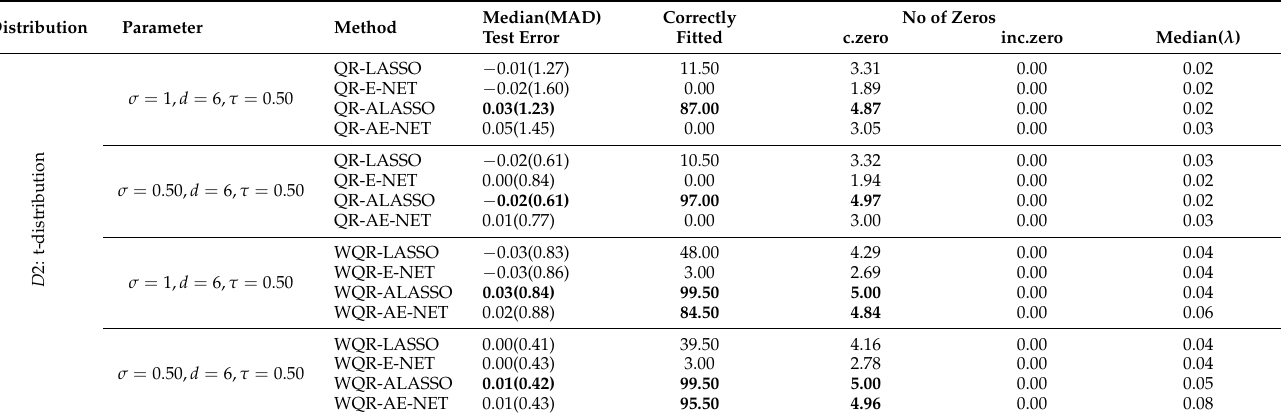
Table A3. Penalized weighted and unweighted quantile regression at D 2 for n = 50 ( τ = 0.50) under the heavy tailed t-distribution.